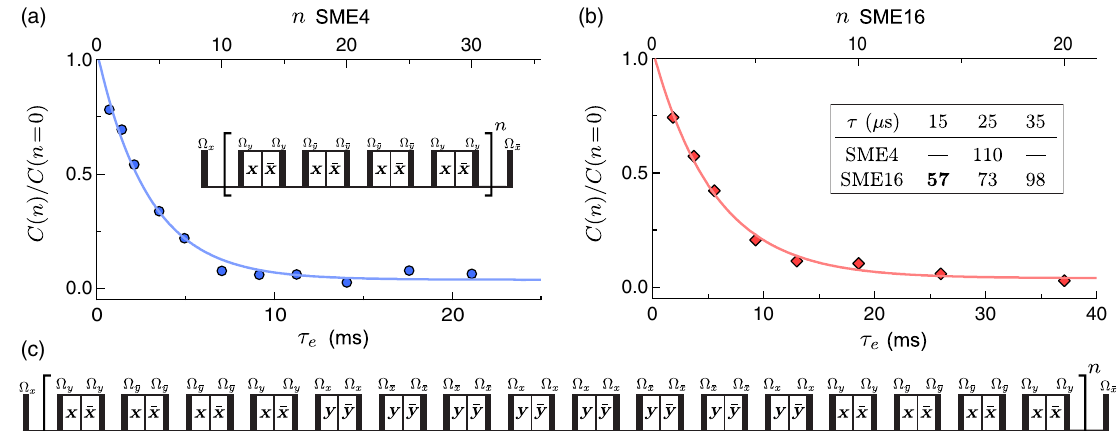
FIG. 4. Normalized spin echo measurements as a function of total encoding time (bottom axis) and number of sequences repeated (top axis) for sequential applications of an SME4 decoupling sequence. The time axis represents the total encoding time, which includes the free evolution and rotary evolution periods, and the duration of the OCT-AHT pulses. Exponential decay curves are fit to the data and used to determine the coherence time T c . (a) SME4 data ( τ ¼ 25 μ s, T c ¼ 2 . 9 ms). (Inset) SME4 pulse-sequence block diagram. (b) SME16 data ( τ ¼ 15 μ s, T c ¼ 5 . 6 ms). (Inset) Table of calculated linewidths Δ ν in units of Hz for sequential application of different SME sequences. (c) SME16 pulse-sequence block